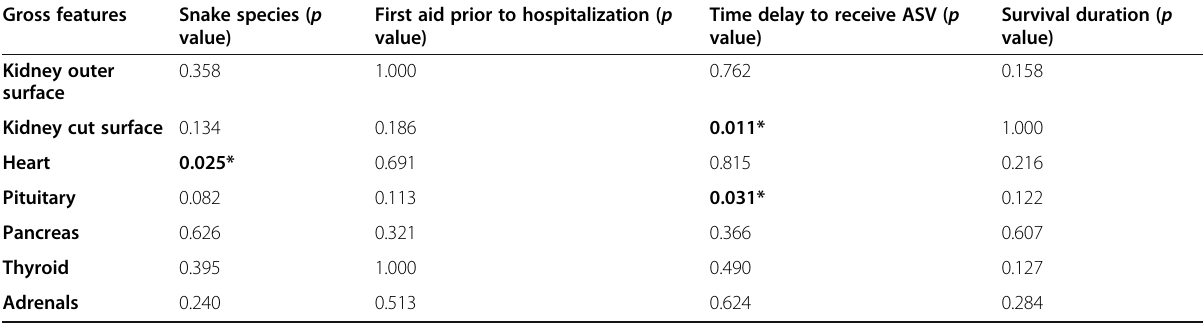
Table 4 Association between the epidemiological factors (snake species, first aid prior to hospitalization, time delay to receive ASV, and survival duration) and gross features of study samples (kidney, heart, and endocrine glands) Gross